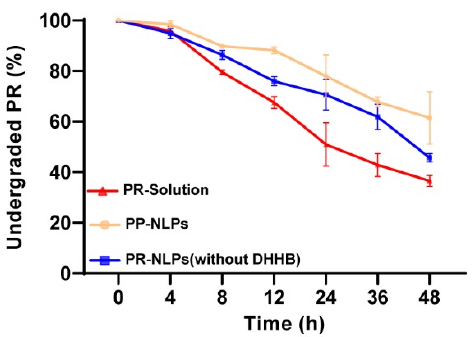
Figure 3. Photodegradation of PR in PR-NLPs (without DHHB), PR-NLPs, PR-Solution after UVA irradiation (n=3, mean value ± SD).